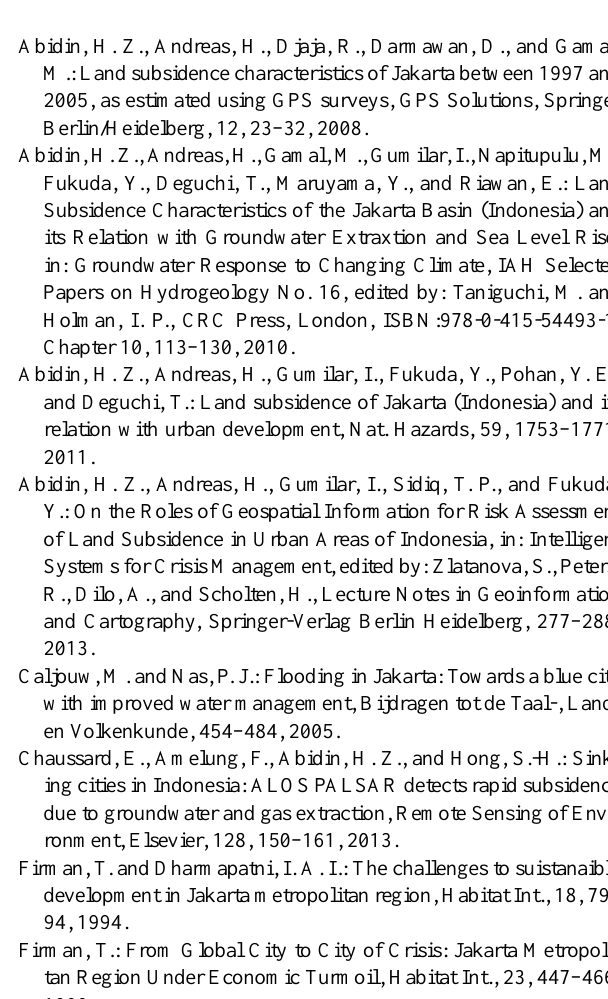
Figure 7. Spatial correlation between InSAR-derived land subsidence (2007–2011) and flooding area in Jakarta (2013).